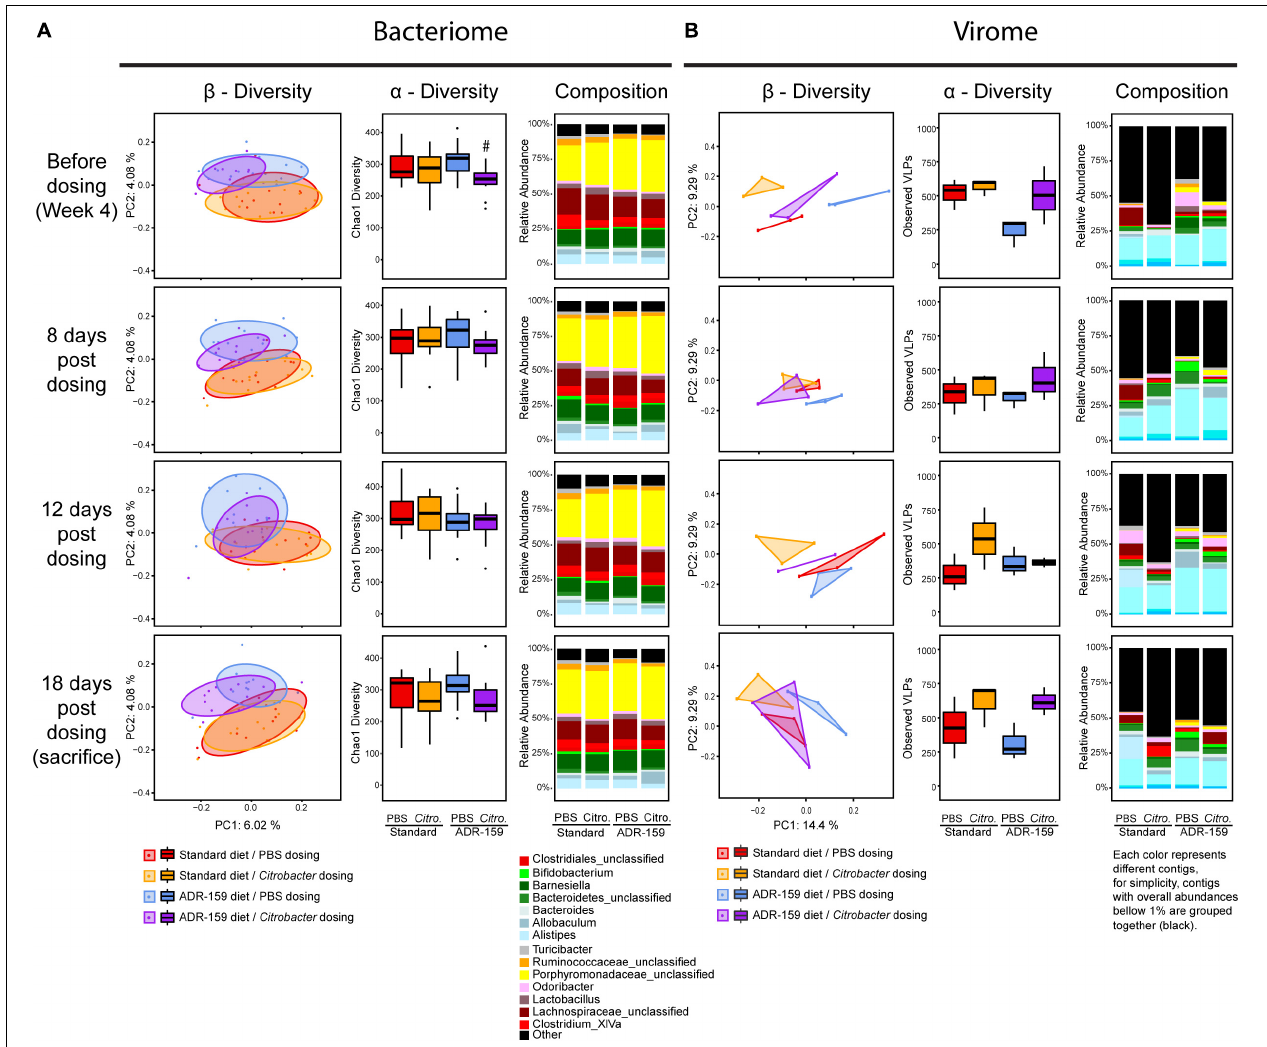
FIGURE 3 | Microbiome analysis of standard (red and orange) and ADR-159 (blue and purple) fed animals before and 8, 12, and 18 days post-initial dosing with PBS (red and blue) and Citrobacter (orange and purple). (A) Bacteriome. Each group represents 12 animals. Left: PCoA plots of microbiome composition using Jaccard distances. Each dot represents individual animal at each given time point. Ellipses represent the confidence interval of every group at 75%. Middle: Chao1 index. Right: mean abundance at genus level. For simplicity, genera with abundances below 1% were grouped together. (B) Virome. Each group represents 3 cages, each of 4 animals. Left: PCoA plots of virome composition using Spearman distances. Each dot represents cage of 4 individual animal at each given time point. For visualization, a triangle area was imposed representing the presence of up to 3 samples per group. Middle: observed number of viral contigs, * indicates significant difference. Right: mean abundance of viral contigs. Each color represents different contig, for simplicity, contigs with overall abundances below 1% were grouped together